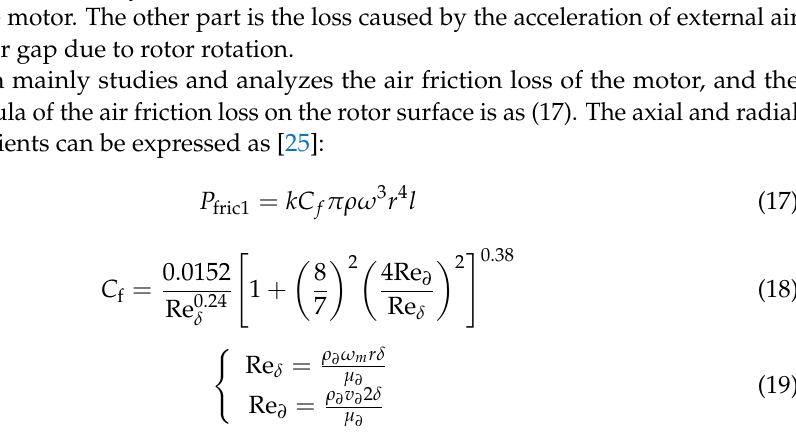
Figure 10. Cross ‐ section view of rotor structure. Figure 10. Cross-section view of rotor